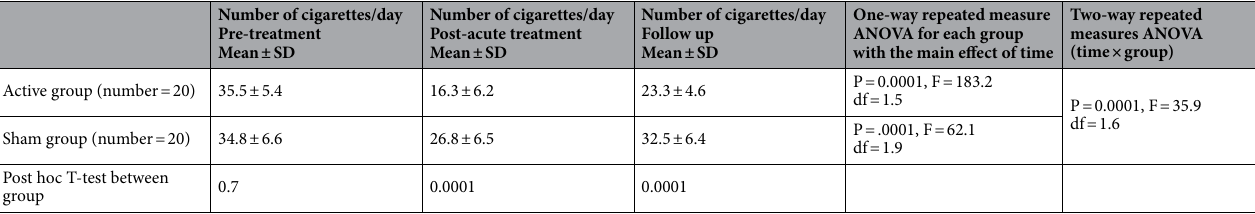
Table 2. Effect of HF-rTMS on the number of cigarettes smoked per day pre-treatment, post-acute treatment and